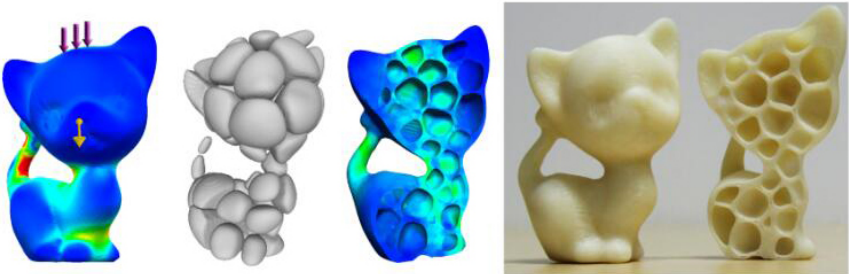
Figure 4. Filled Voronoi (Tyson polygon) structure (Lu et al.,